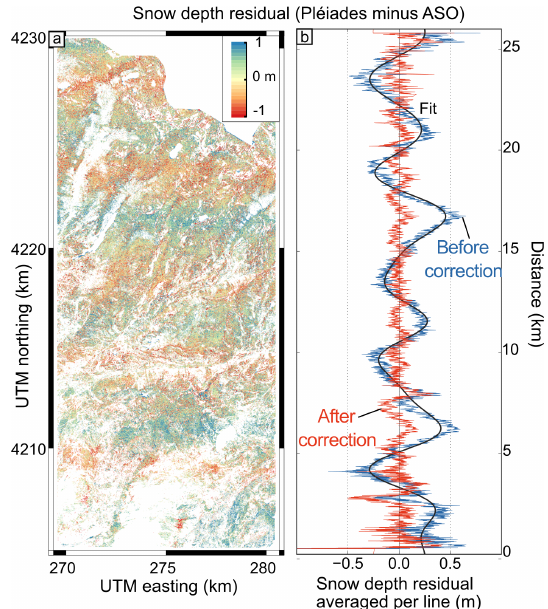
Figure 8. Residual snow depth (Pléiades minus ASO) over the com- plete study area (a) and average per line (b) . In (b) , the HS residual before correction (blue) is corrected for the low-frequency undula- tion (black) to obtain a corrected signal